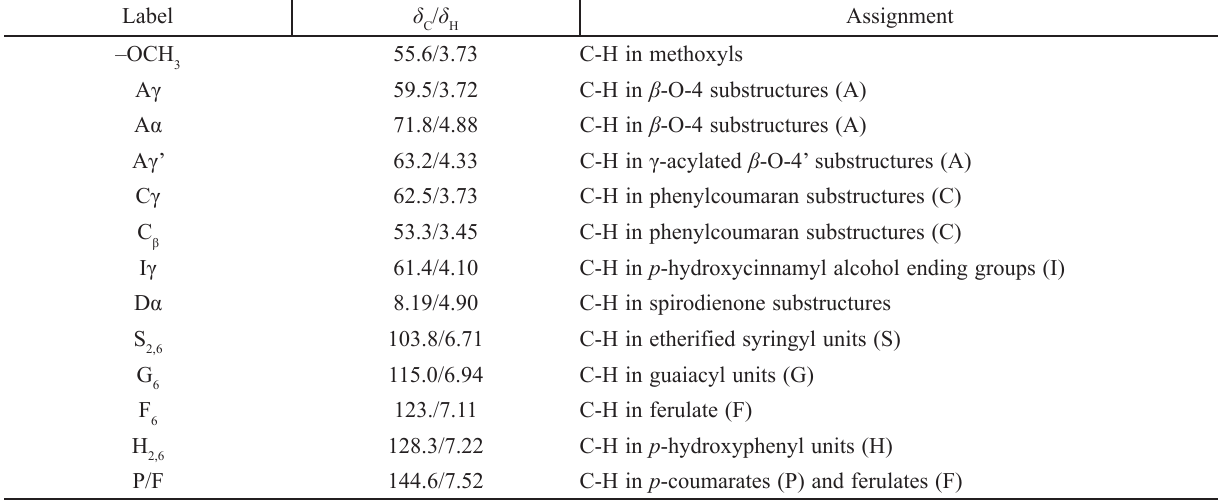
Table S2 – Assignments of 13 C- 1 H cross-signals in 2D HSQc NMR spectra of lignin fractions